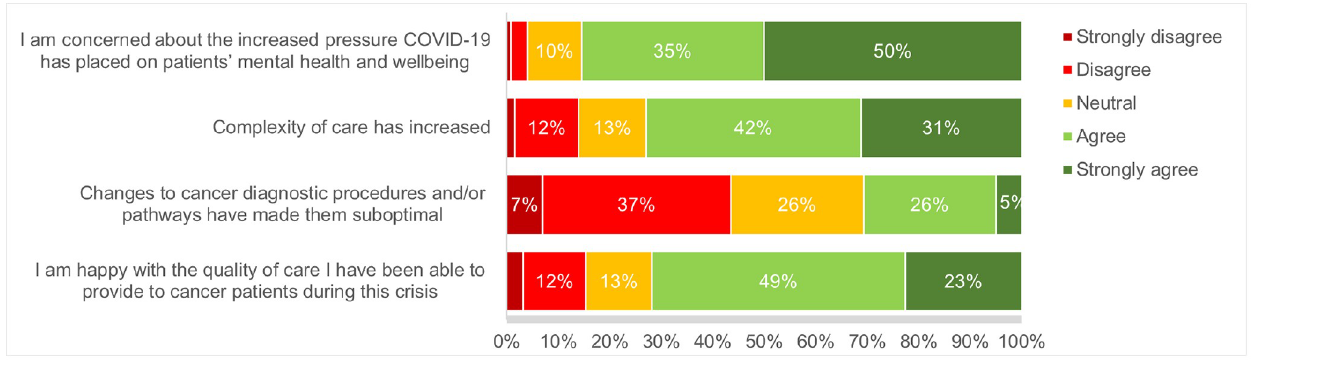
Fig 3. Health worker perceptions of cancer care quality during COVID-19 � . Based on answers to the survey item: ‘To what extent do you agree or disagree with the following statements about cancer care during the COVID-19 outbreak?’. � N/A responses and missing data were excluded from percentage calculations.